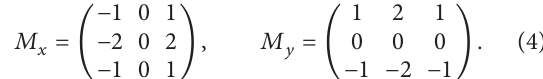
Figure 4: Defined geometry of the alignment mark. (a) Position of alignment mark next to a culture chamber ( left ), extracted edges of the alignment mark ( middle ), and two template images used in the convolution for alignment mark detection ( right ) in the template- matching procedures. Scale bar: 100 𝜇 m. (b) Generated 𝐶 of different matching schemes between the template image and the alignment mark image. We show here a captured microscopic image ( lower )andanideal-caseimage( upper )ofthealignmentmark.Scale bar: 150 𝜇